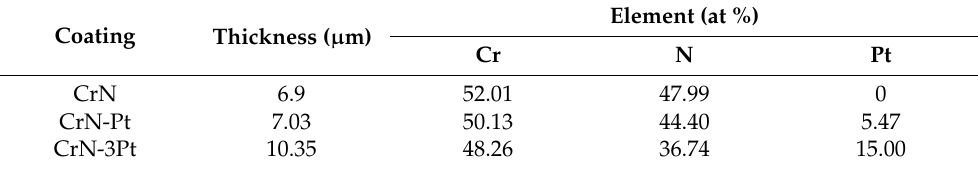
Table 2. Coating